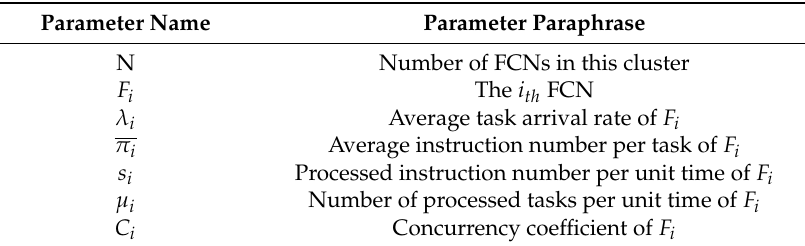
Table 1. Parameter names and